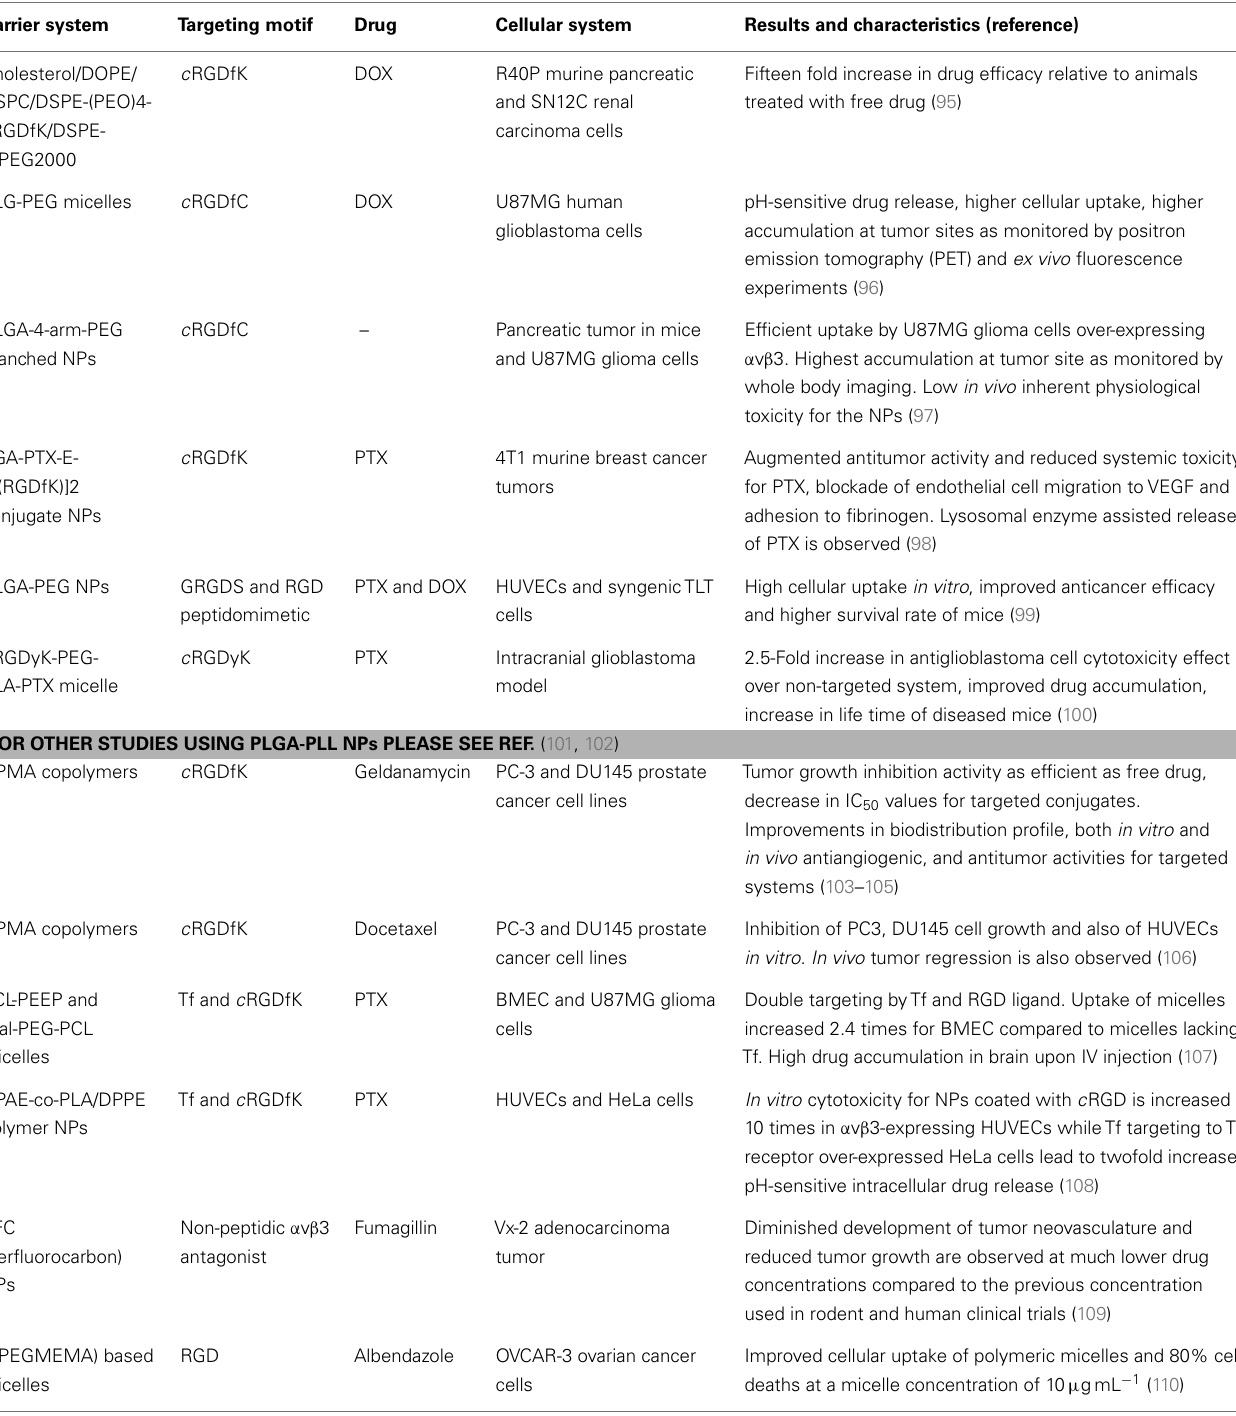
Table 1 | Outline of representative recent examples of polymer-based targeted delivery studies using α v β 3 and/or α v β 5 integrin